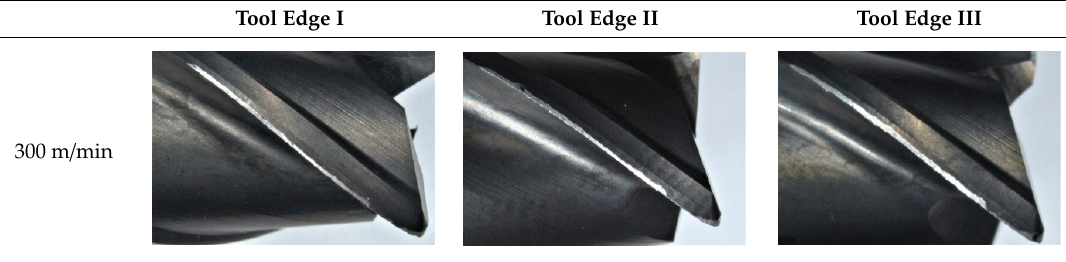
Table 8. State of flank wear VB B after milling with various cutting speed.